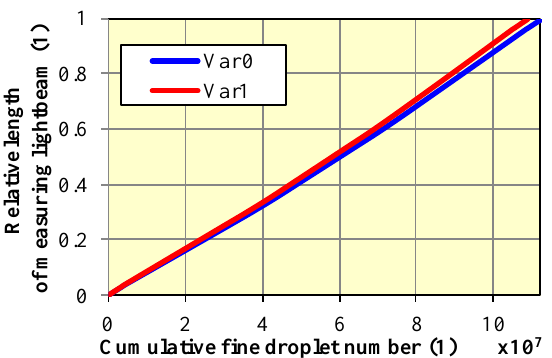
Fig. 6. Cumulative fine droplet number inside the active cylindrical measuring volume